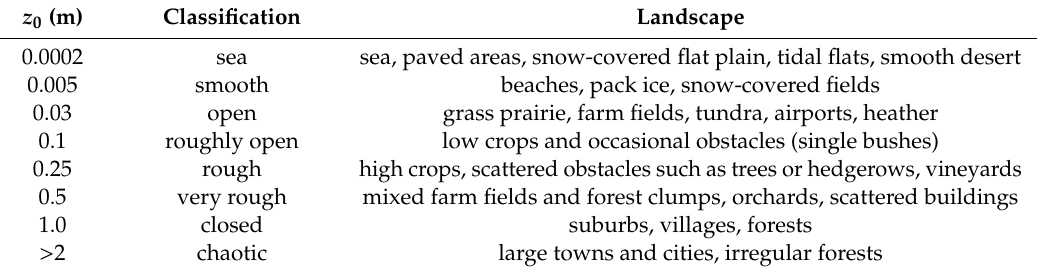
Table A2. Classification of the aerodynamic roughness length, z 0 [33].